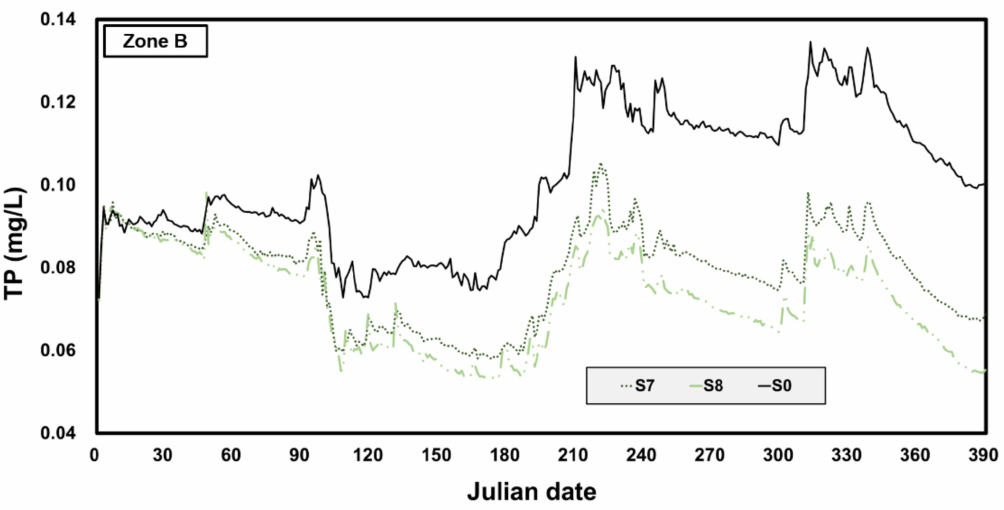
Figure 13. Simulated results of T-P concentration (Zone B, S0,